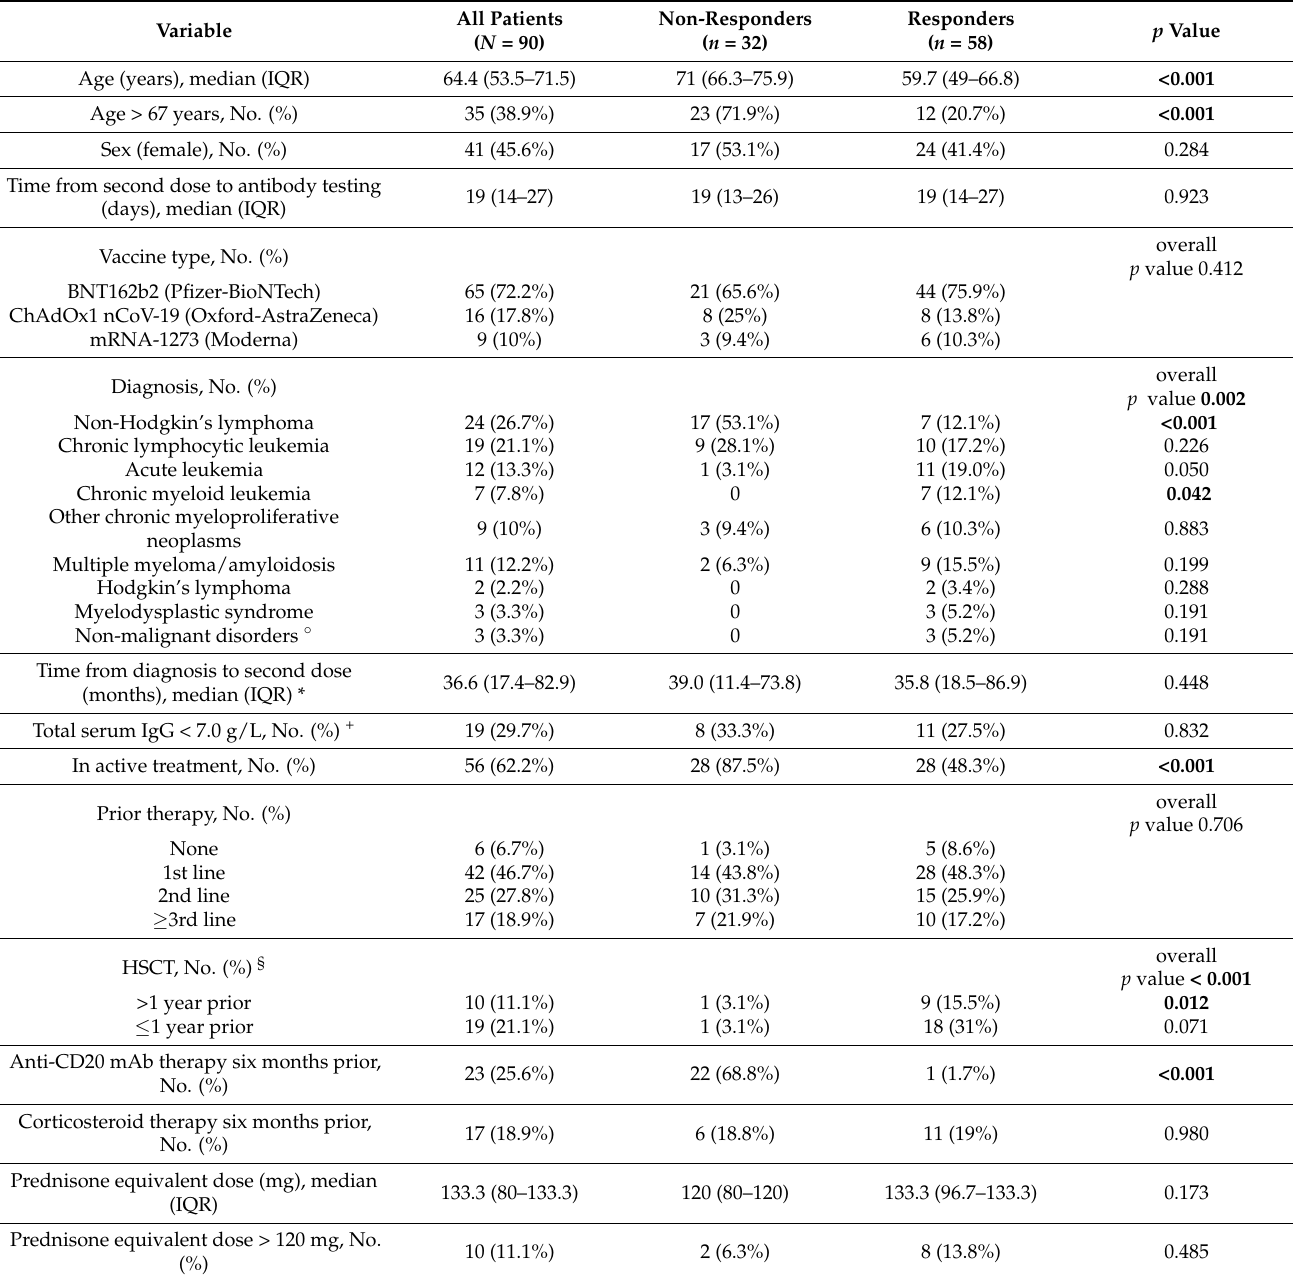
Table 1. Patient characteristics with regards to humoral response after two vaccine doses, defined as > 0.8 U/mL of serum anti-SARS-CoV-2 spike protein receptor-binding domain